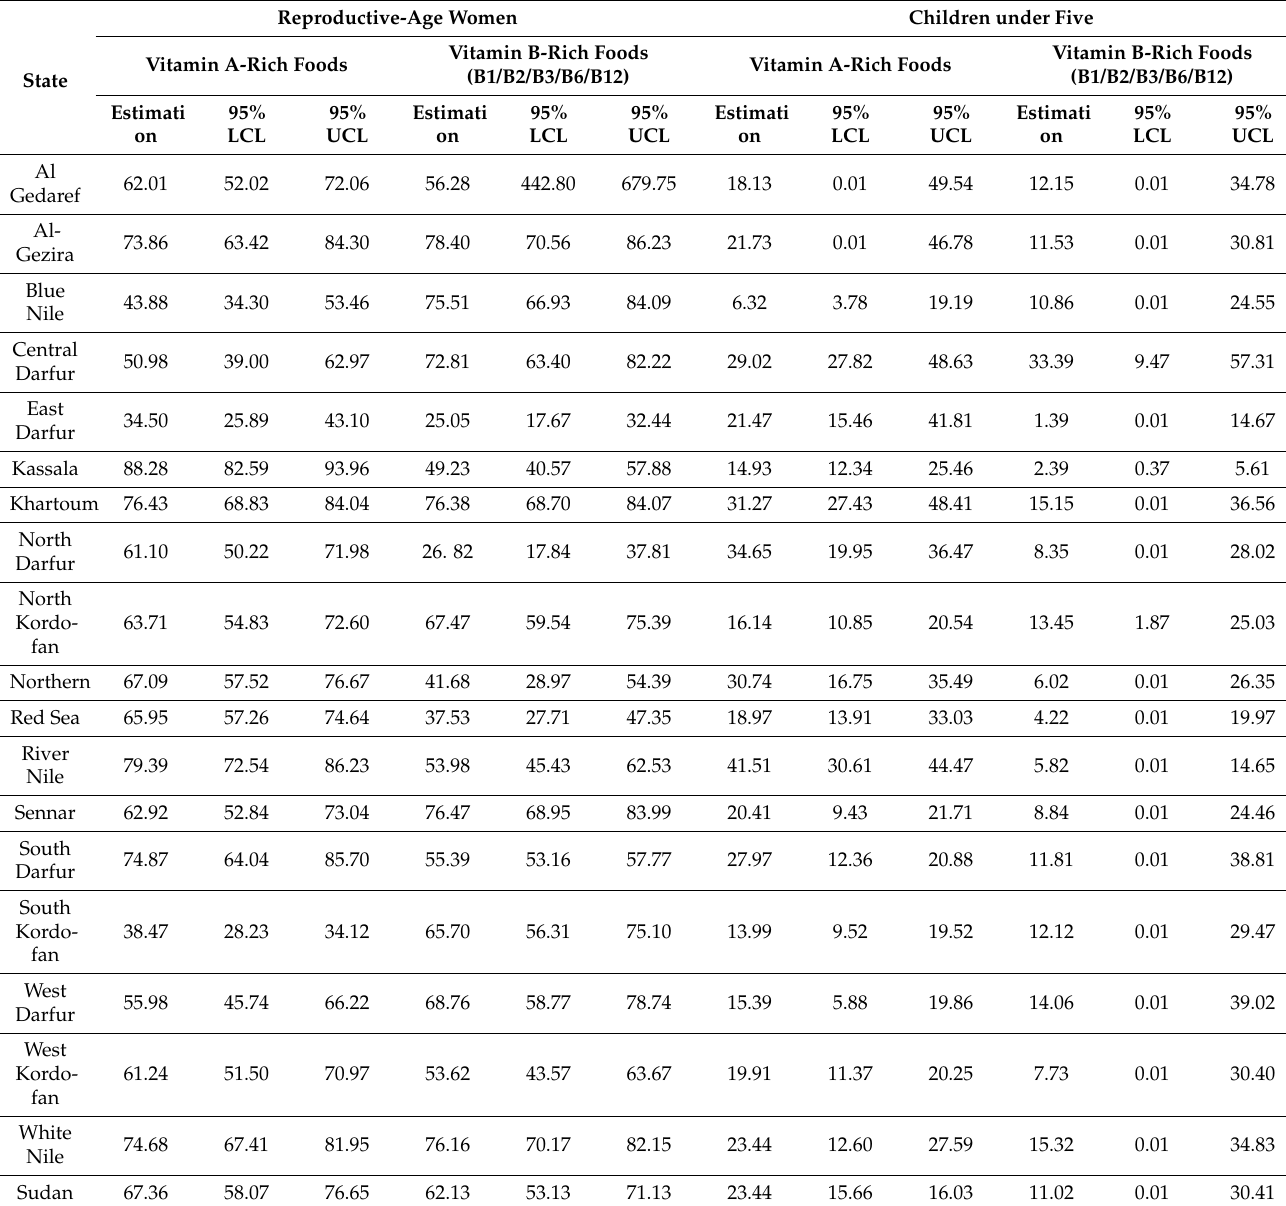
Table 4. Consumption of vitamins-rich foods among reproductive-age women (15–49 years of age) and their children. Reproductive-Age State